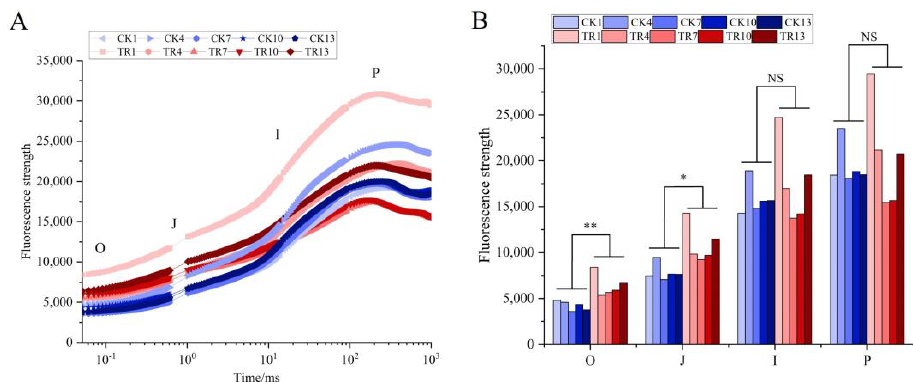
Figure 1. Effect of PWN on rapid chlorophyll fluorescence induction kinetic curves of P.